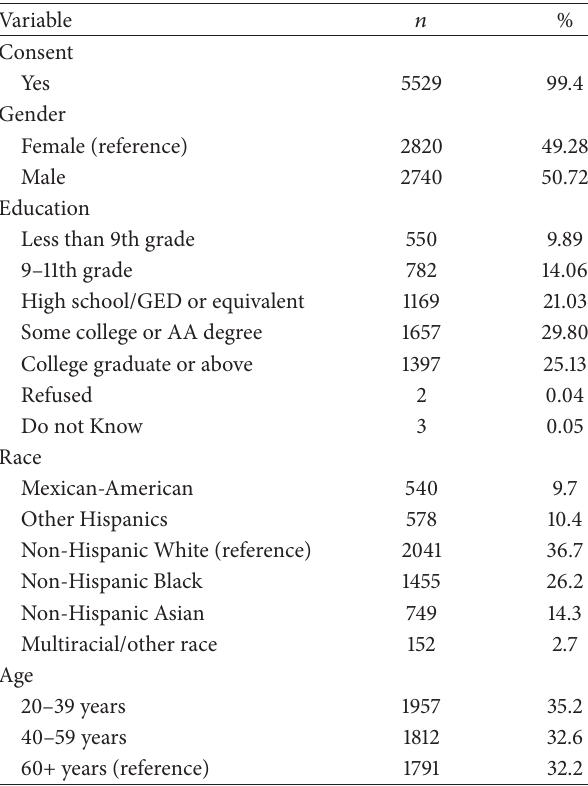
Table2:Relativeoddsforconsenttobiospecimenstorageandfuture research in adult participants of the 2011-2012 NHANES aged 20 years or more.